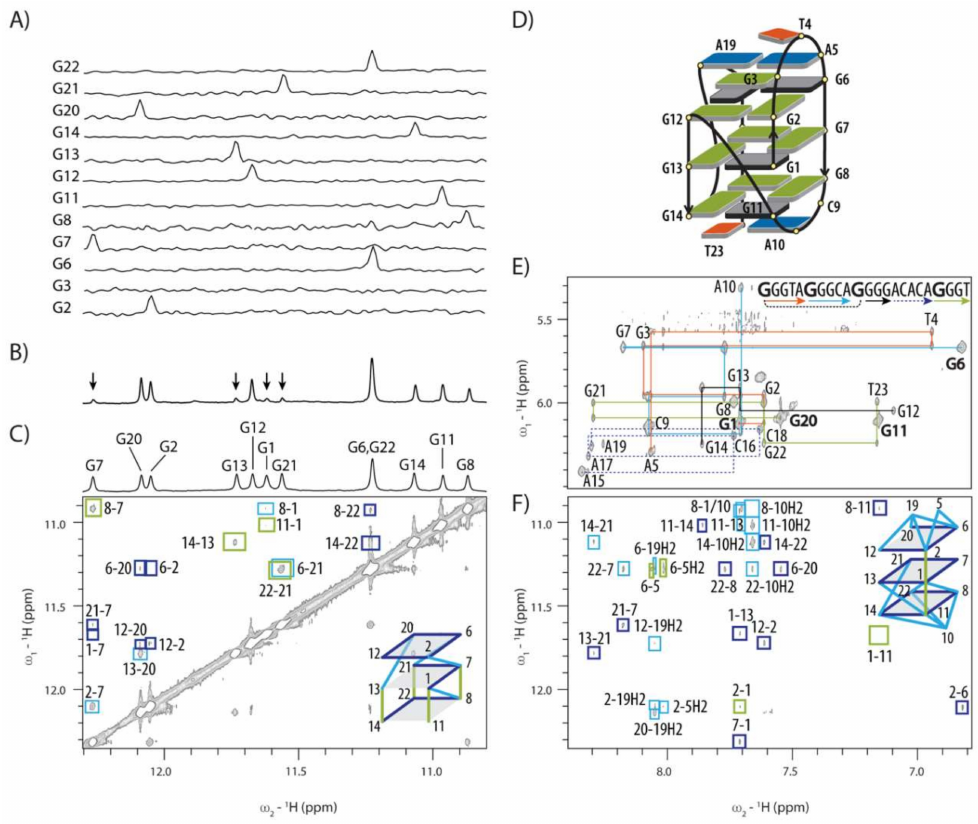
Figure 2. Topology determination of HPV52 (1–4) . ( A ) 1D 1 H- 15 N HSQC spectra of site-specific partially labelled oligonucleotides for identification of guanine residues in the G-quadruplex core. ( B ) Imino region of 1 H-NMR spectrum 5 min after D 2 O-H 2 O exchange. Arrows point to the resonances of the least water accessible imino protons. ( C ) Imino-imino region of 2D NOESY spectrum ( τ m 250 ms) with assigned contacts between pairs of imino protons and schematics of correlations within G-quadruplex core. ( D ) Topology of HPV52 (1–4) , where residues with extensive contacts to G-quadruplex core are shown with rectangles. Guanine residues in syn and anti -conformation, thymine and adenine residues are shown in dark grey, green, orange and blue colours, respectively. ( E ) Anomeric-aromatic region of 2D NOESY spectrum with sequential walk along the oligonucleotide sequence. ( F ) Imino-aromatic region of 2D NOESY spectrum with assigned connectivities between H1 and H8 pairs of protons within G-quadruplex core and contacts that define position of loop residues. Spectra were recorded at 25 ◦ C, pH 7, 50 mM [K + ] and c oligo between 1.0 and 2.7 mM. 2D NOESY was recorded with τ m of 250